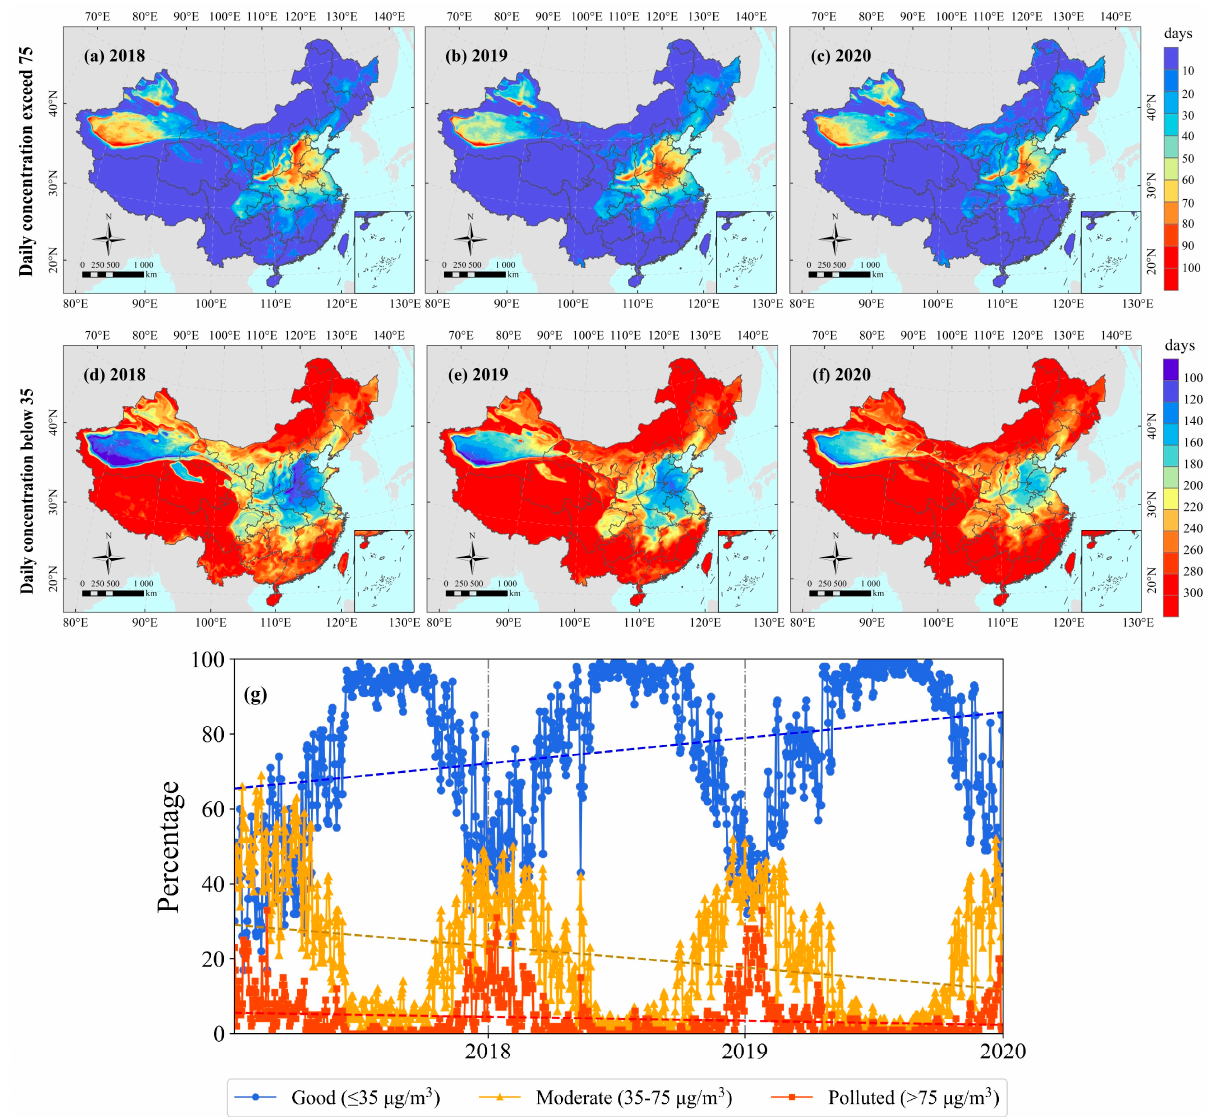
Figure 6. Number of days per year ( a – f ) and percentage of area per day ( g ) for three PM 2.5 pollution levels (All of the linear trends were significant at p -level < 0.05).